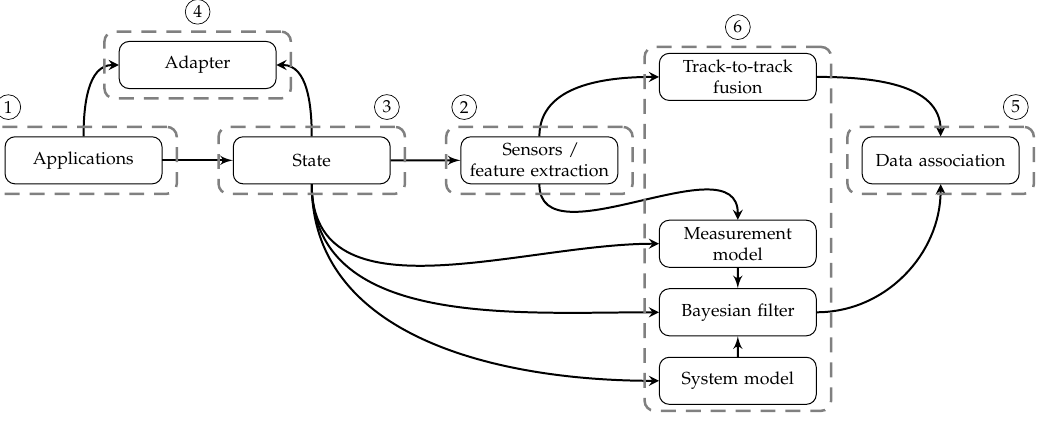
Figure 3. Constraints between decisions made in different steps of the